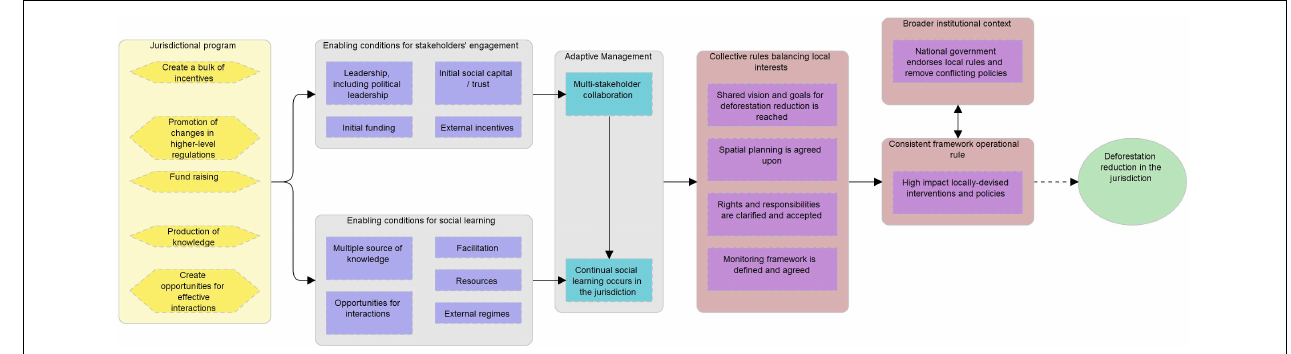
FIGURE 1 | Generic theory of change chain for JA drafted with Miradi software.